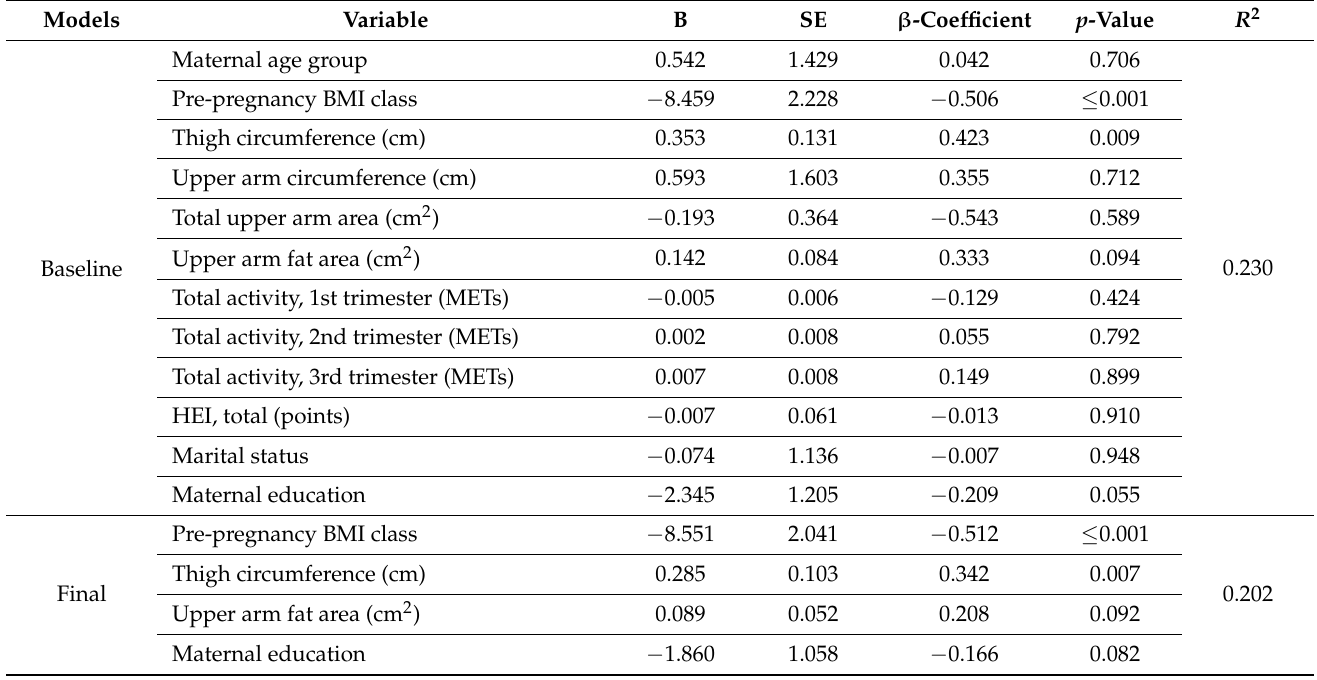
Table 5. Multiple linear regression: gestational weight gain (GWG) as an outcome variable (baseline and final model, n = 98).